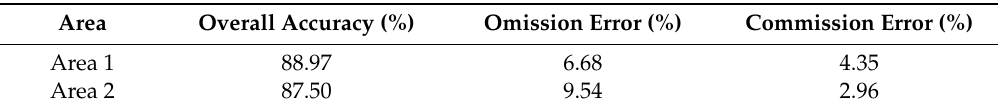
Table 1. The overall accuracy of the two